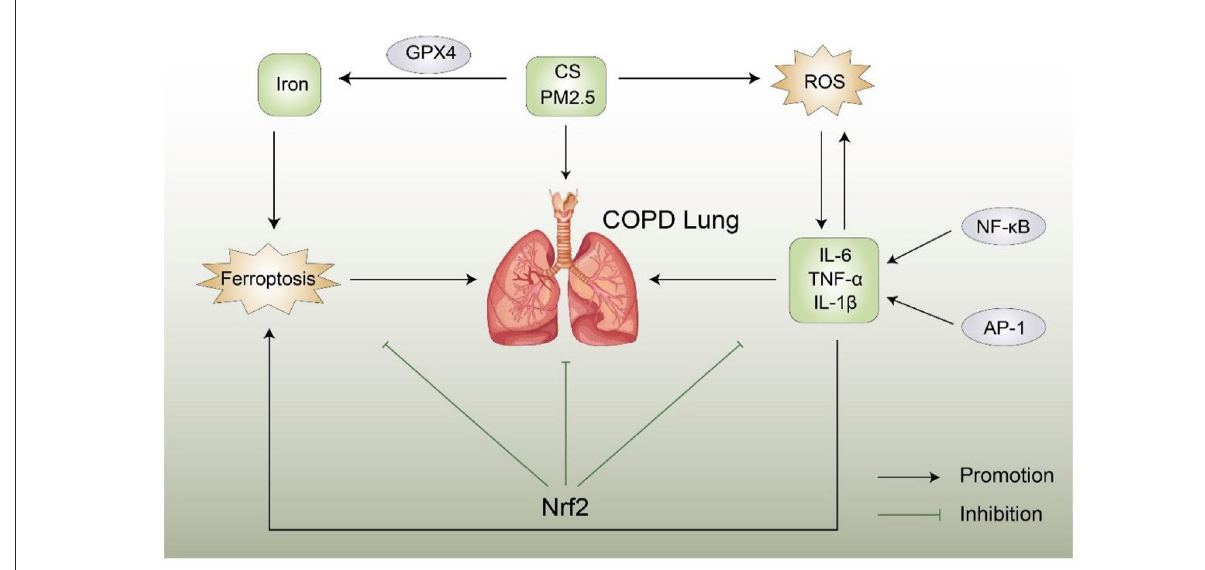
FIGURE2 Possible relationship between ferroptosis and COPD, ROS, CS, and PM2.5 trigger COPD, resulting in an inflammatory reaction and abnormal levels of inflammatory factors. Conversely, abnormal inflammatory factors can aggravate COPD, Nrf2 can inhibit the production of reactive oxygen species and iron and the occurrence of COPD and ferroptosis. A direct link between ferroptosis and COPD remains unclear. Nrf2, Nuclear factor erythroid 2-related factor 2; CS, cigarette smoke; ROS, reactive oxygen species; AP-1, activator protein 1; NF- κ B, nuclear factor of kappa